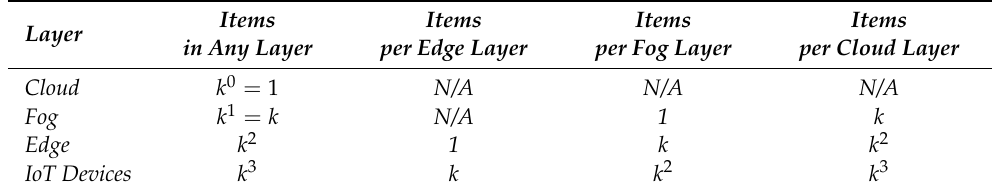
Table 3. Number of devices for each layer in a full mesh interfog scenario within the MEC frame- work